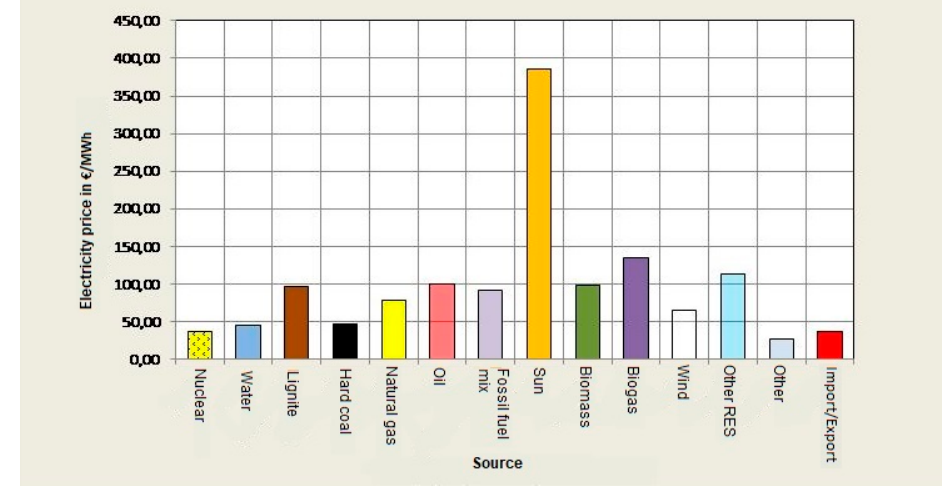
Figure 1. Comparison of commodities end user prices (Source: [31,32]).